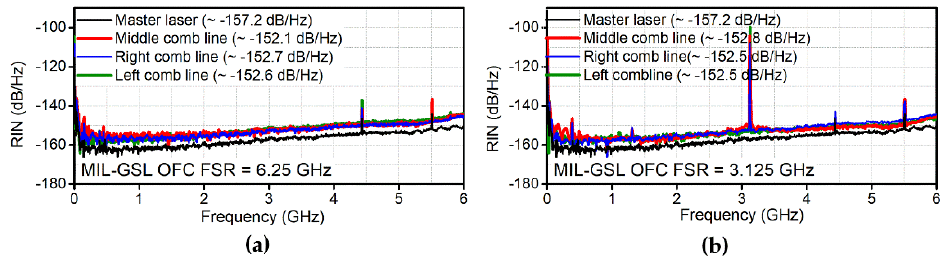
Figure 7. Relative intensity noise measurements for MIL-GS OFC of FSR ( a ) 6.25 GHz; ( b ) 3.125 GHz. Table 4. Summary of the MIL-GSL OFC phase noise and RIN